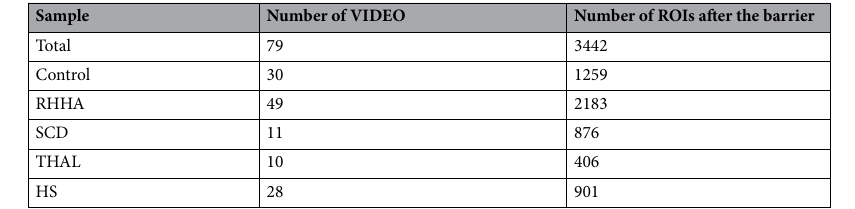
Table 1. Number of videos and ROIs analyzed in the study. The numbers in the table represent the number of videos recorded during the experiments and the number of ROIs extracted from the corresponding videos. Numbers are listed considering the total of the individuals included in the study, then divided in categories. ROI Region of interest, RHHA rare hereditary hemolytic anemia, SCD sickle cell disease, THAL thalassemia, HS hereditary